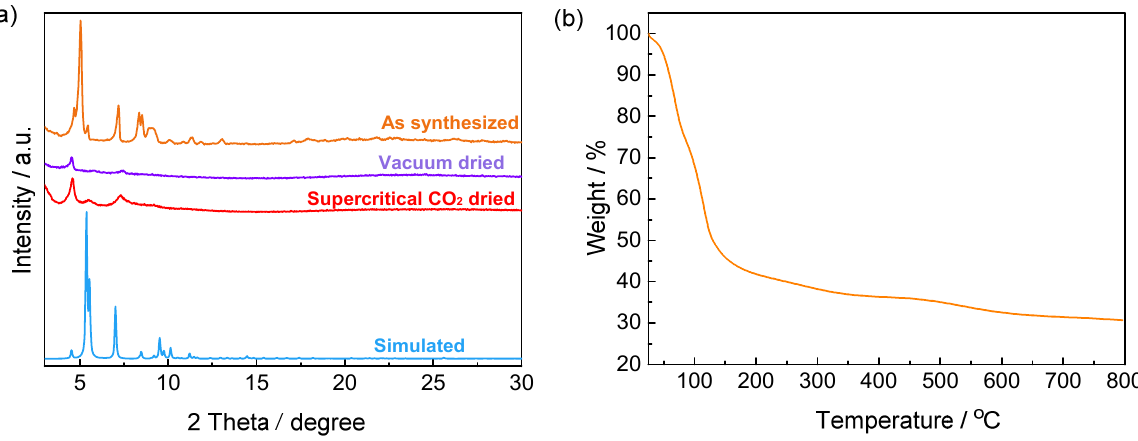
Figure 2. ( a ) PXRD patterns of Zr-MOF-P under different conditions. ( b ) TGA profile of Zr-MOF-P .